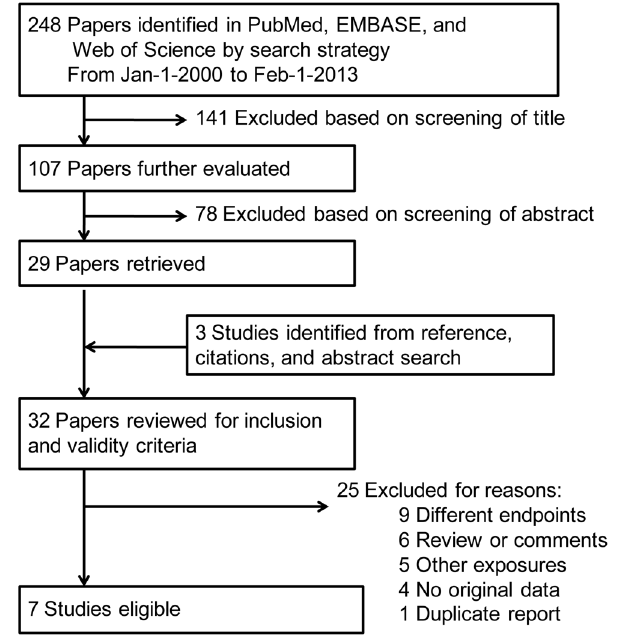
Figure 1. The literature search process.